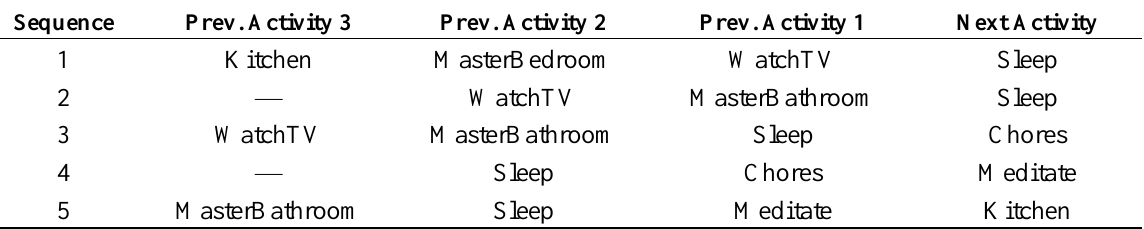
Table 2. Representative sequences from behavioral patterns.